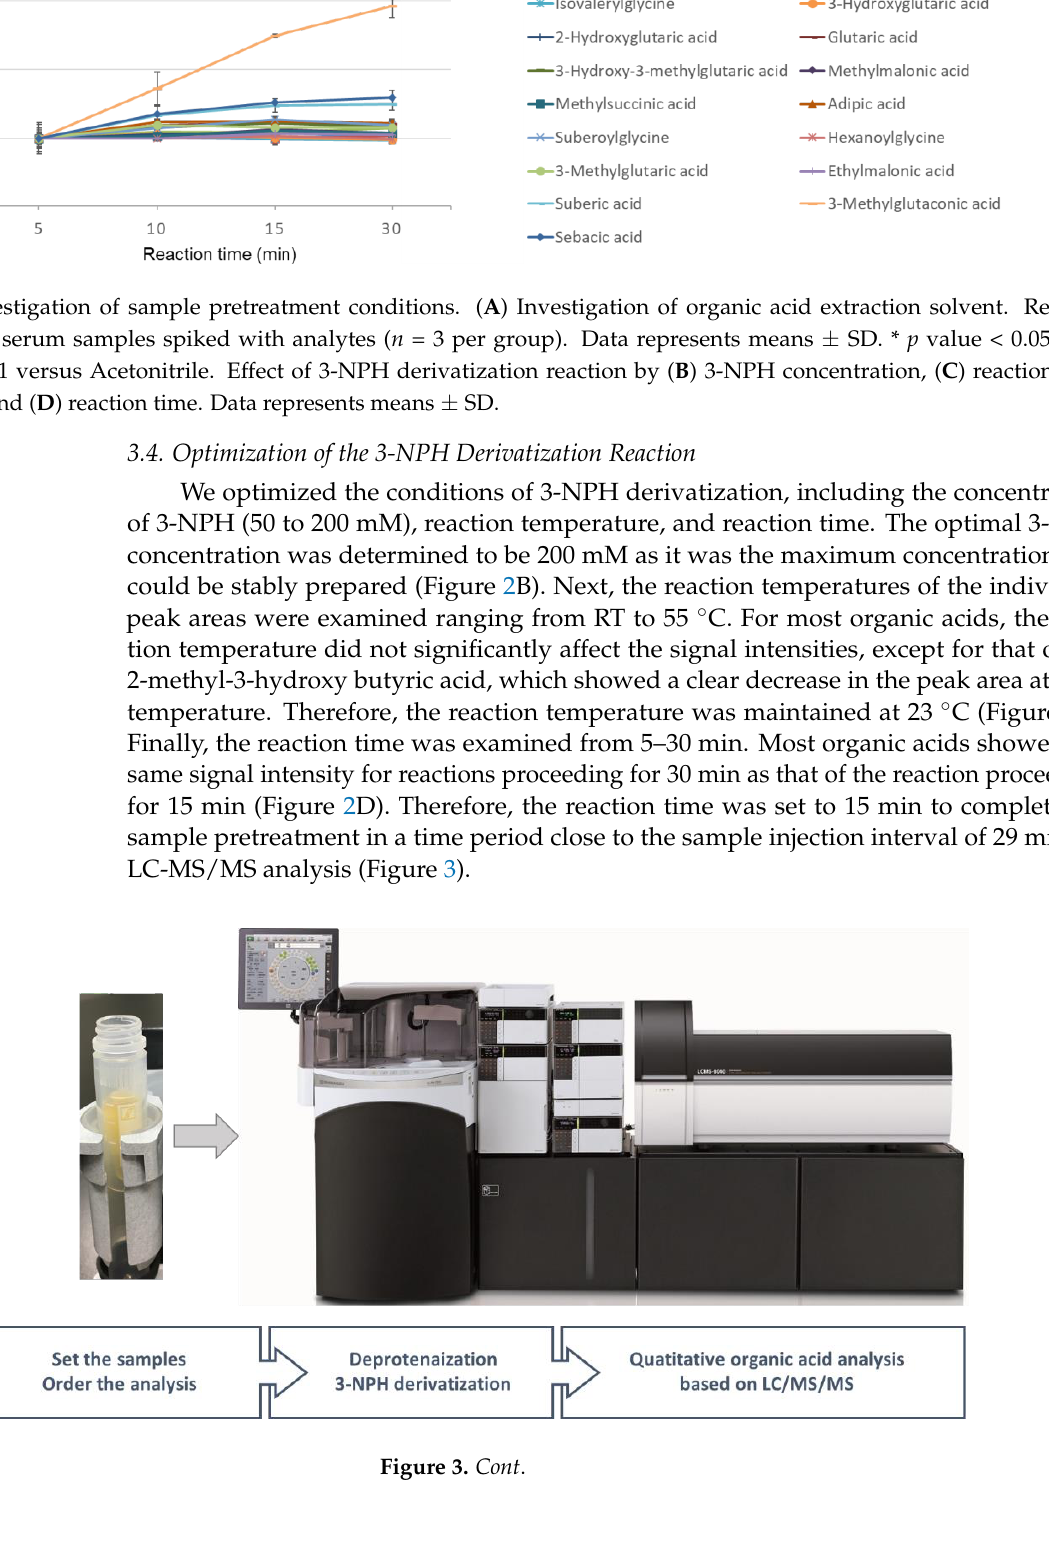
Figure 3. Fully automated organic acid analysis system. ( A ) Schema of the analysis system. ( B ) Flow of sample measure- ment. The next sample pretreatment can be performed during LCMS analysis. 3.5. Linearity, Sensitivity, Accuracy, and Imprecision The quantification parameters of our system for 19 serum organic acids were deter- mined (Table 2). The correlation coefficients of the calibration curves ranging from 2 – 100 µM were more than 0.992 for all analytes. The LLOD was 0.06 µM for most analytes and was detectable for all analytes from a concentration of at least 0.50 µM (methylsuccinic acid). The accuracy of the assay over five consecutive measurements was adequate (within 15%), with a maximum error of 14.1% at 5 µM and 7.5% at 25 µM. Simultaneous repro- ducibility ( n = 5) and inter-day reproducibility ( n = 5) were 10.4 and 5.7% CV, respectively (both within 15%). Table 2. Result of validation study. r 2 : correlation coefficient of the calibration curves ranging 2 – 100 µM. LLOD: Low limit of detection. LLOQ: Low limit of quantification. Compounds